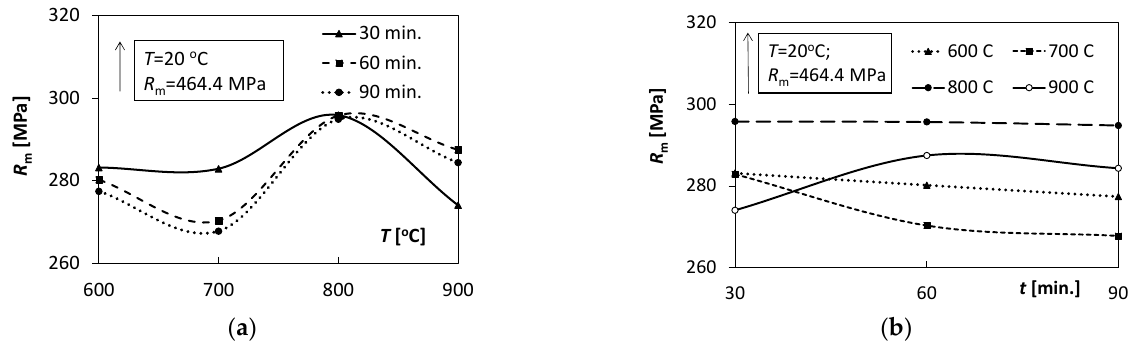
Figure 6. Variability of the value yield point R p 0.2 depending on: ( a ) temperature T , ( b ) annealing time t .